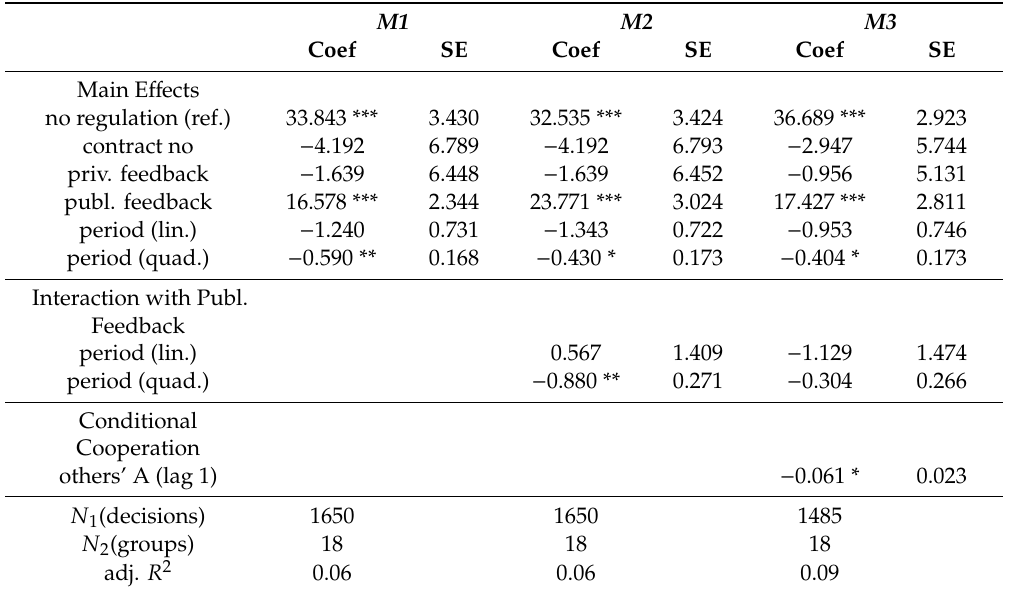
Table 2. Determinants of subjects’ investment in Asset B.